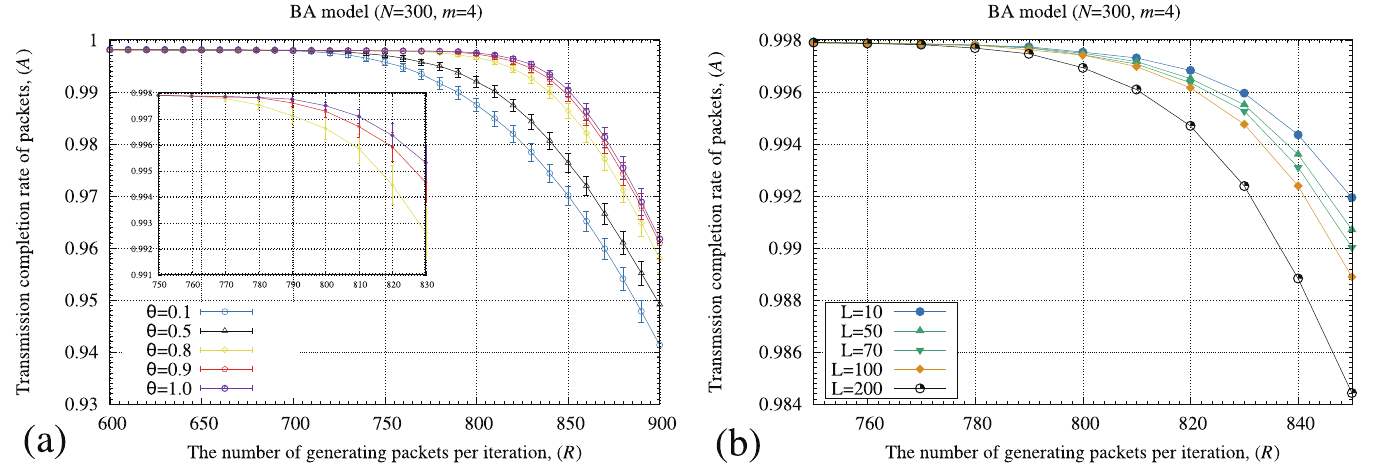
Fig 7. Relationships between the number of generating packets at each iteration ( R ) and a transmission completion rate of packets ( A ) for different L and θ values applied for the memory-pauto method. In these figures, the standard deviation of each method is plotted as error bars. In these numerical experiments, we used the BA